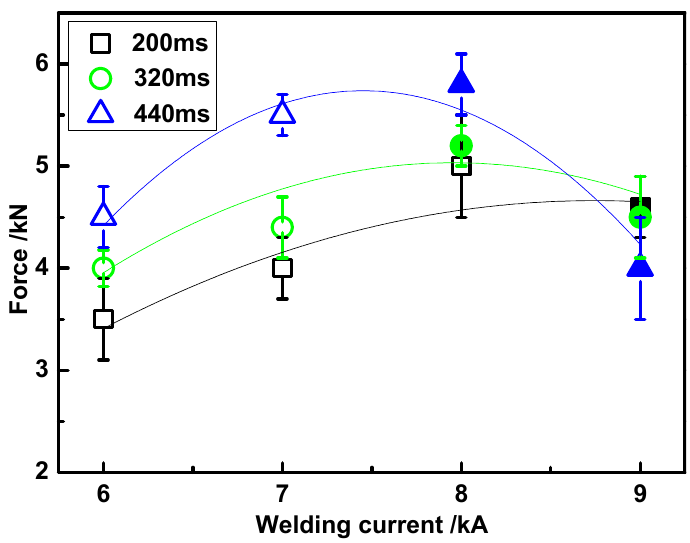
Figure 3. CTS and failure modes of resistance spot welded 1.2 mm thick MS1400 steel.